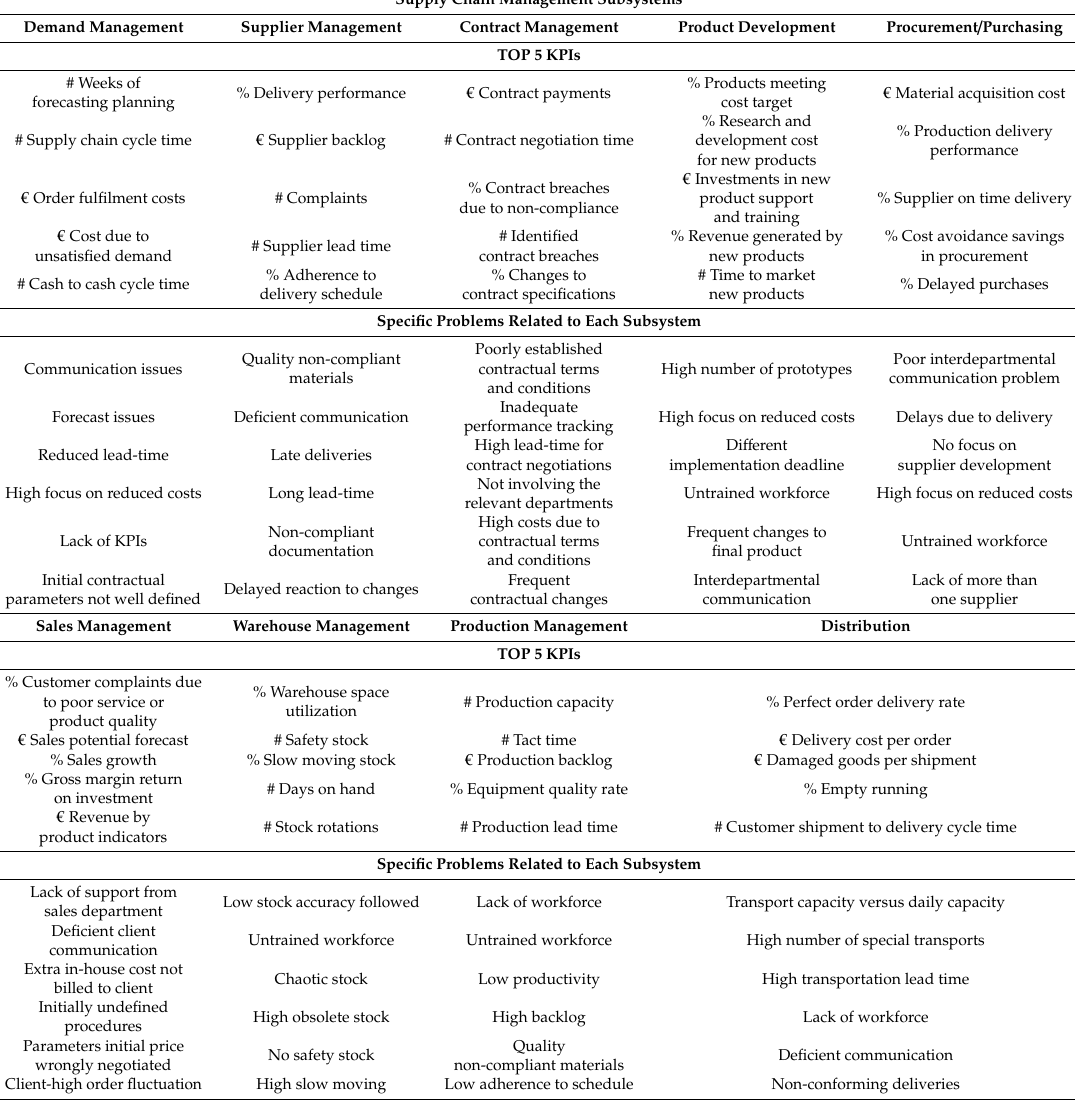
Table 1. Top five key performance indicators (KPIs) and top problems identified for each supply chain management (SCM)